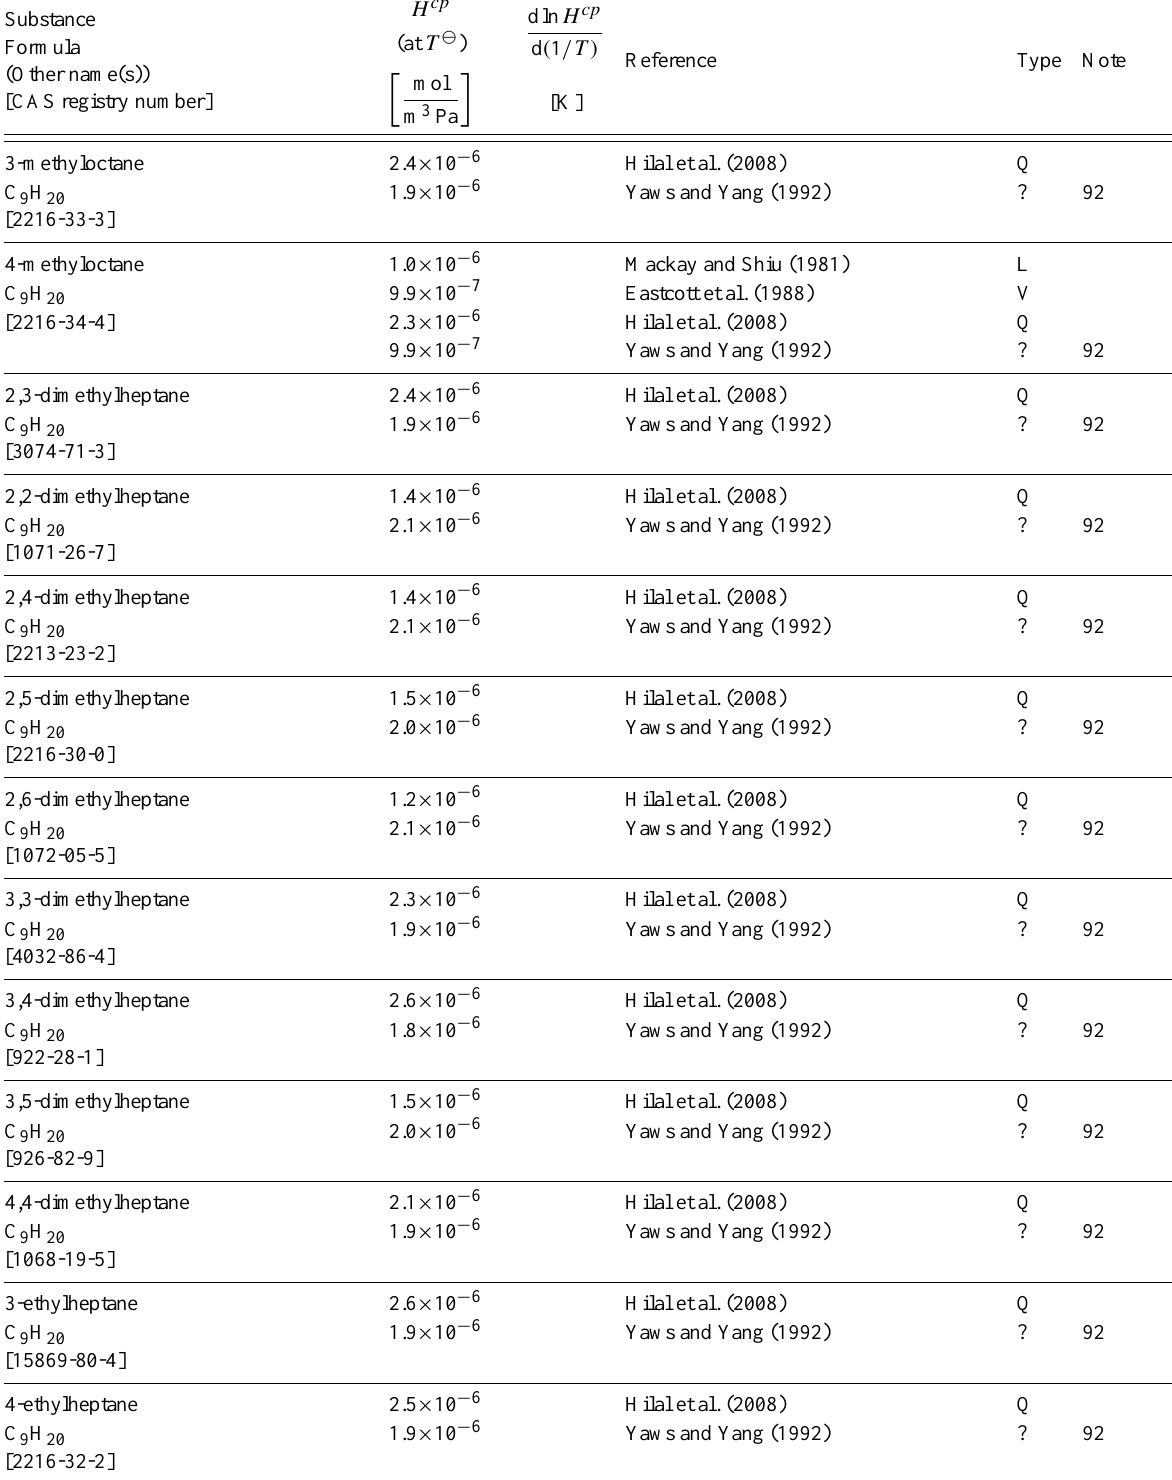
Table 6: Henry’s law constants for water as solvent